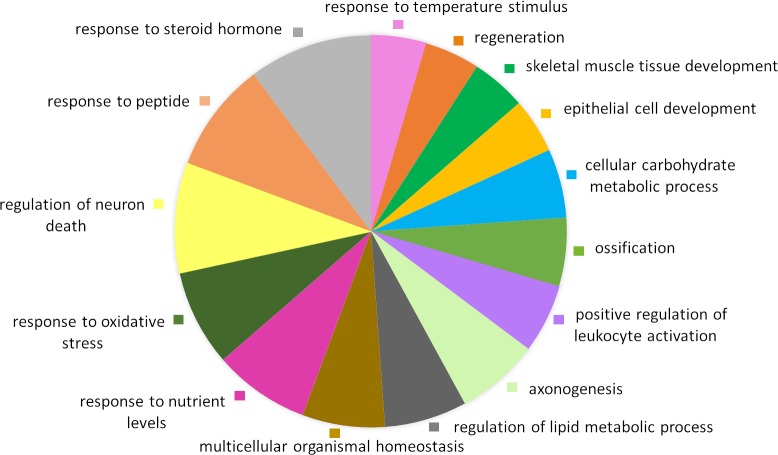
Gene Ontology analysis showing significantly enriched biological processes among upregulated DEGs in the muscle of RSM pigs in comparison to SBM pigs.Biological processes represented by less than 4 genes were excluded.